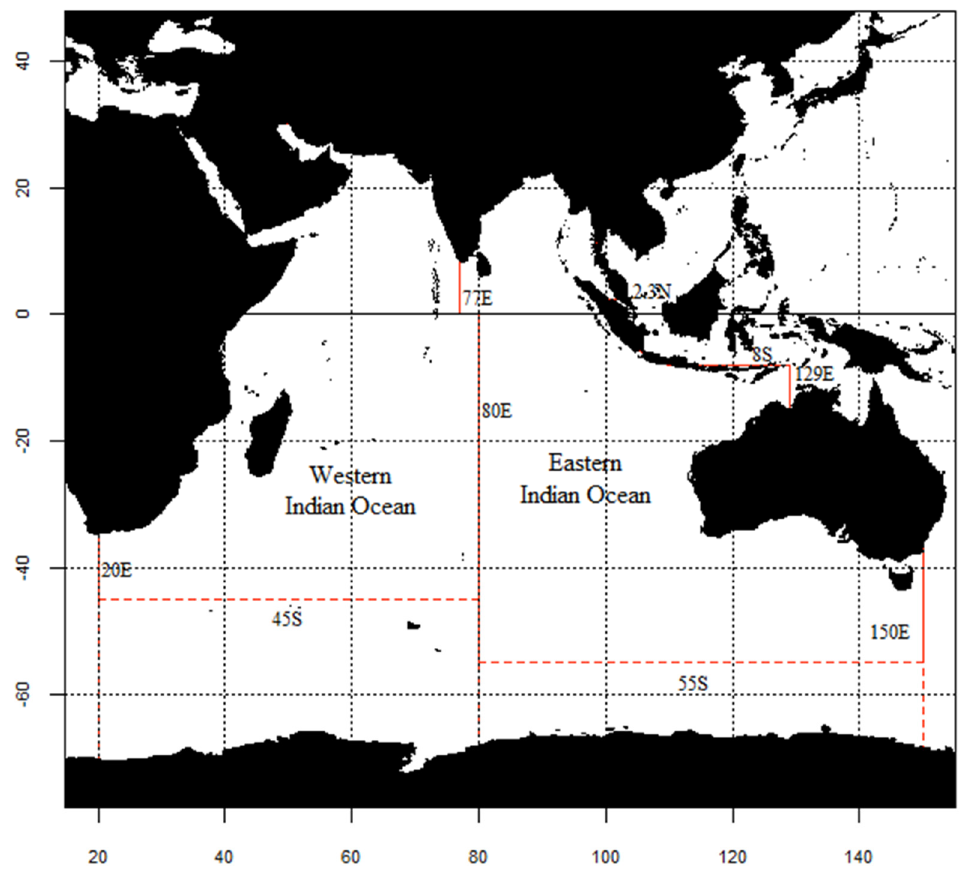
Figure 4. IOTC area of competence. Source: IOTC website. Reproduced from [33], with permission from Indian Ocean Tuna Commission, 2022.